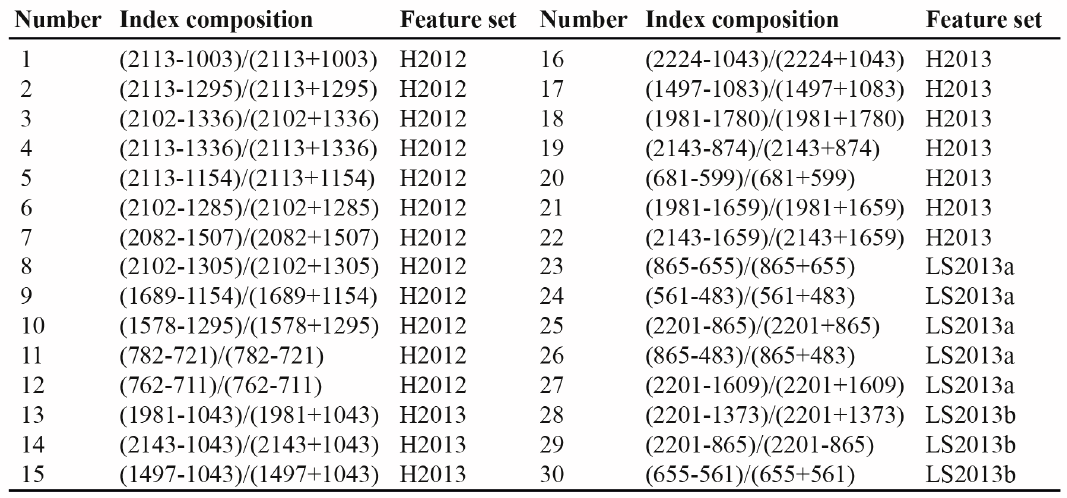
Figure 5. Occurrence of the 10 most frequently chosen NDIs according to stepwise variable selection from all folds and repetitions (1000 selections) with feature sets ( a ) H2012, ( b ) H2012, ( c ) LS2013a and ( d )